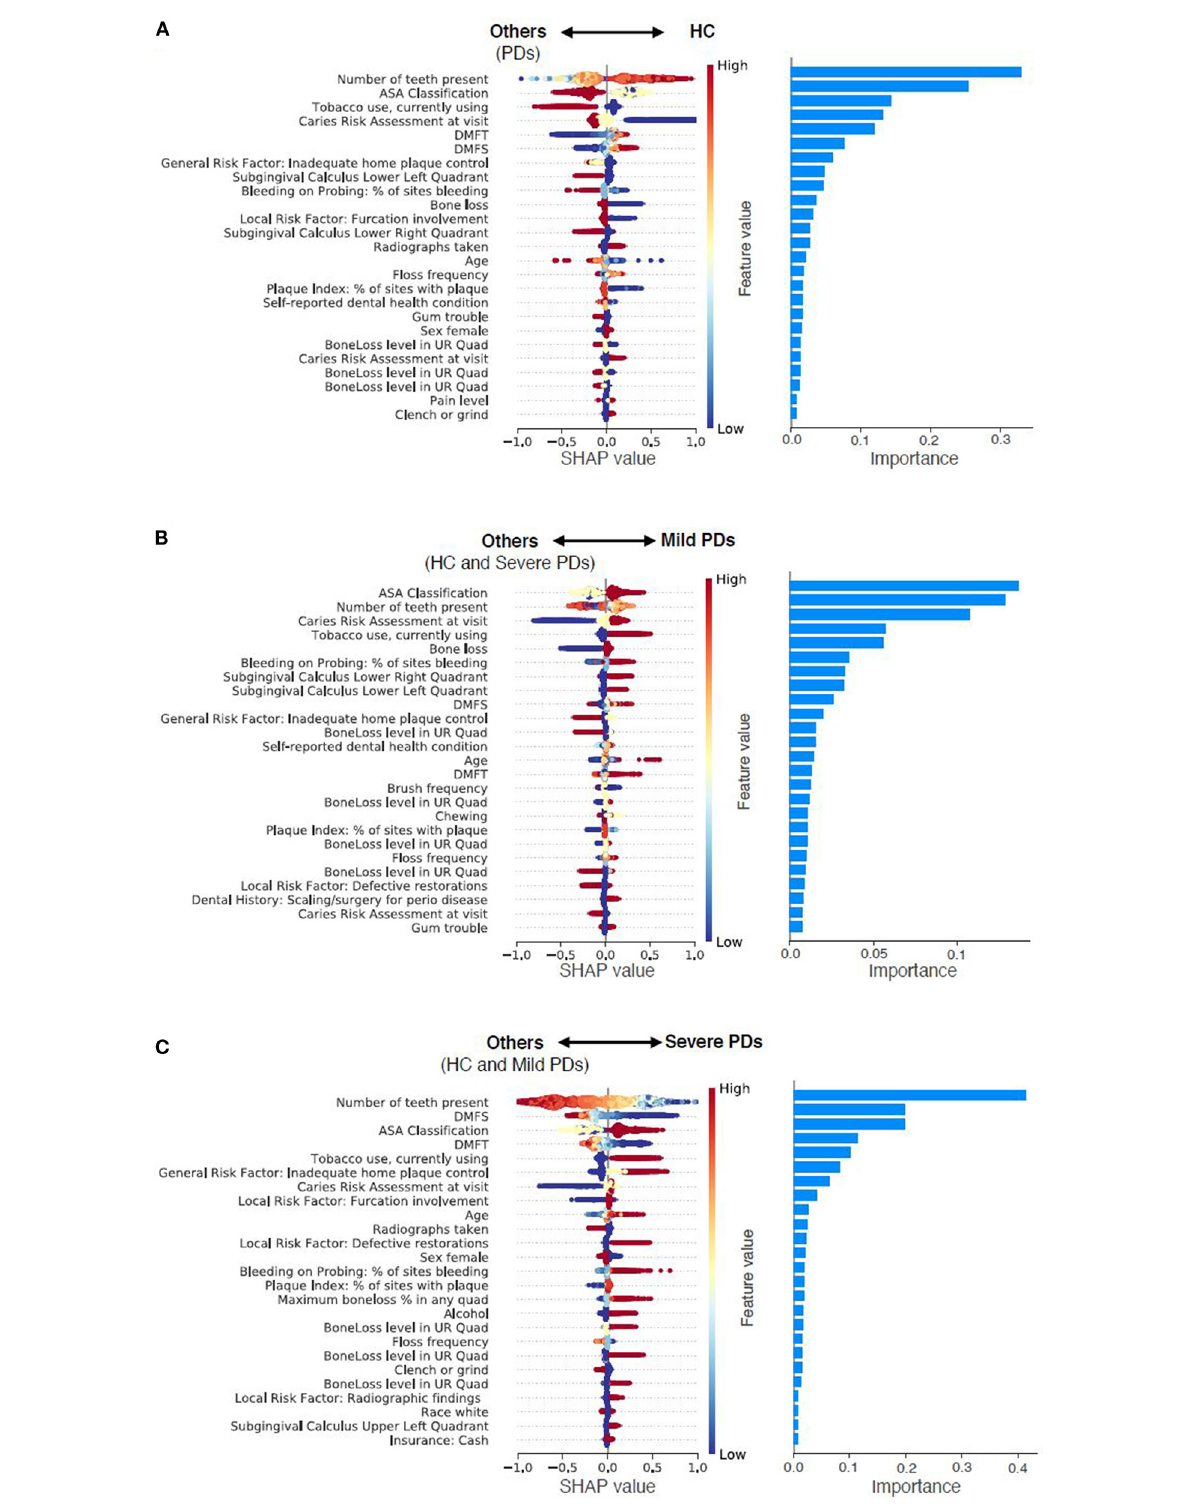
FIGURE4 Predictor contributions. Contributions of top 25 predictors in predicting HC from PDs (A) , predicting Mild PD from others (HC and Severe PD) (B) , and predicting Severe PD from others (HC and Mild PD) (C) . For the left column, each dot indicates a sample, color density of the dot indicates normalized value of the specific feature of the specific sample, and horizontal axis indicates SHAP values. High positive SHAP value